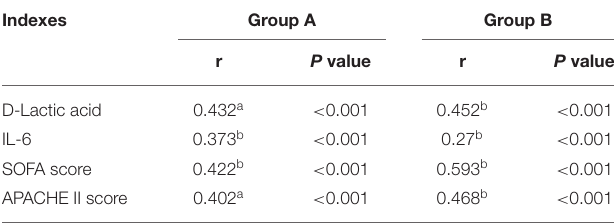
TABLE 3 | Correlation results of FC with IL-6, SOFA score and APACHE II score.